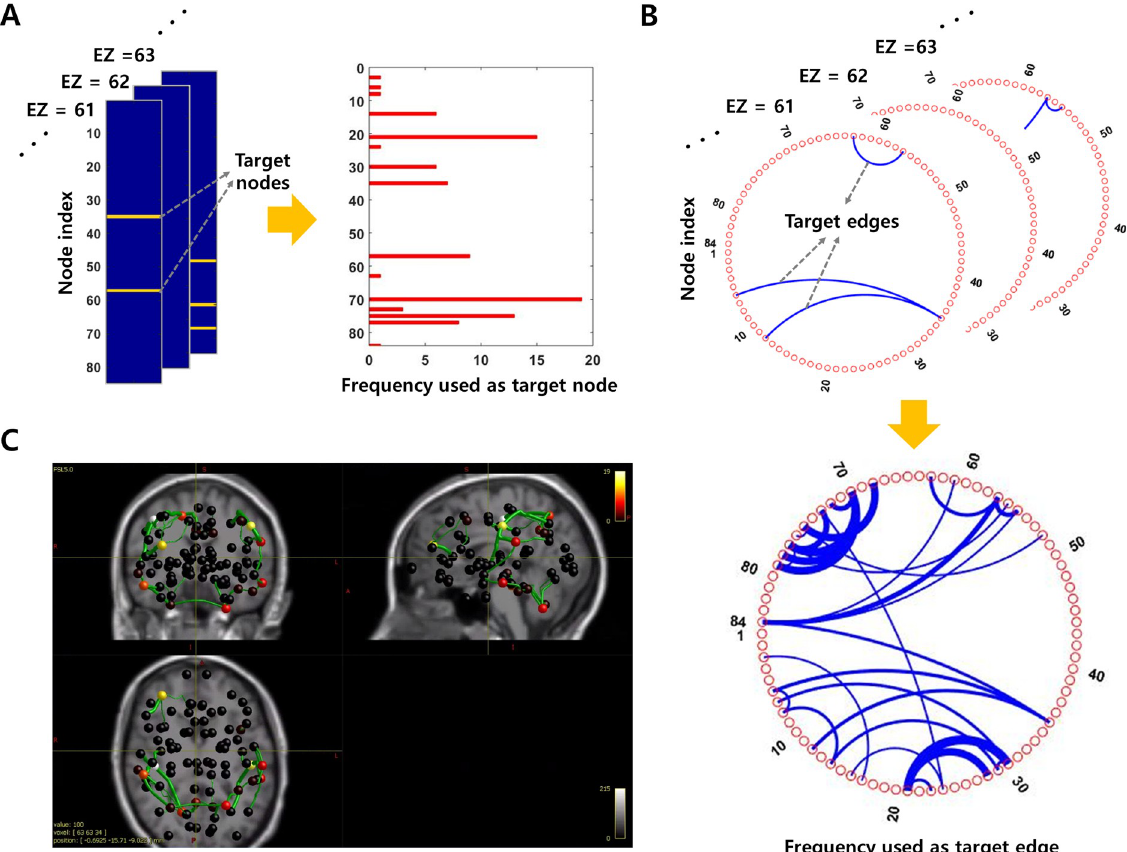
Fig 6. TZs depending on the location of EZ. A Target nodes according to the location of EZ and their cumulative results. Orange points in each column indicate the target nodes, when EZ is located in each different node. B Target edges according to the location of EZ and their cumulative results. Connection lines between nodes in each slice indicate the target edges, when EZ is located in each different node. The cumulative result identifies several nodes and edges frequently used as TZ. Here, the resolution parameter for the modularity analysis is set to 1.0. C Anatomical locations of the nodes and the edges frequently obtained as TZ. The color code of nodes and the thickness of edges indicate the frequency used as TZ.